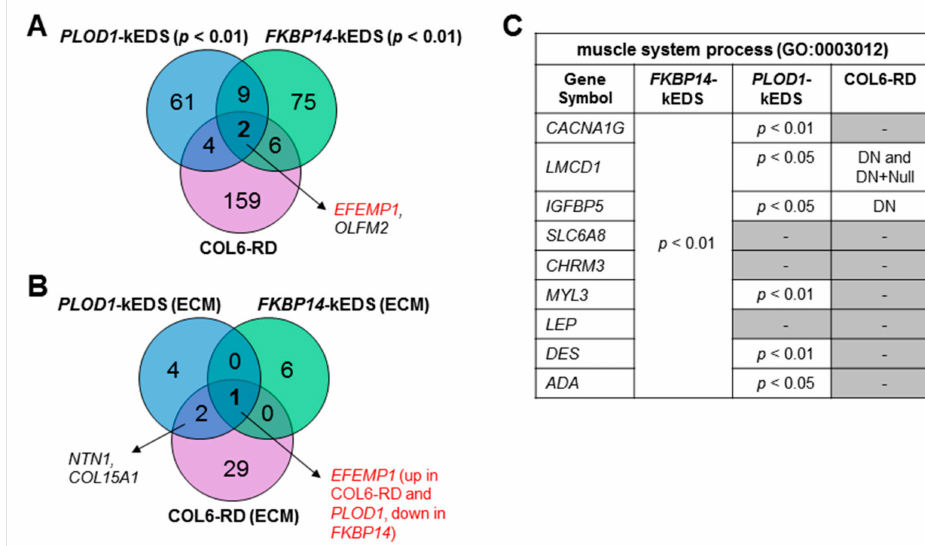
Figure 4. Comparison of transcriptome profiles of PLOD1 -kEDS, FKBP14 -kEDS and collagen VI-related muscular dystrophies (COL6-RD) patient-derived fibroblasts. ( A ) Venn diagram depicting number of overlapping and non-overlapping DEGs among three patient groups. ( B ) Venn diagram depicting number of overlapping and non-overlapping DEGs encoding ECM components among three patient groups. ( C ) List of genes contributing to over-representation of muscle system process in FKBP14 -kEDS versus control fibroblasts and significance of their di ff erential expression in PLOD1 -kEDS and COL6-RD fibroblasts. DN = dominant negative COL6-RD mutations allowing incorporation of abnormal collagen VI chains; Null = recessive COL6-RD mutations that do not allow incorporation of abnormal chains as described in Butterfield et al., 2017; gene expressions that are non-significantly altered are represented by dashes